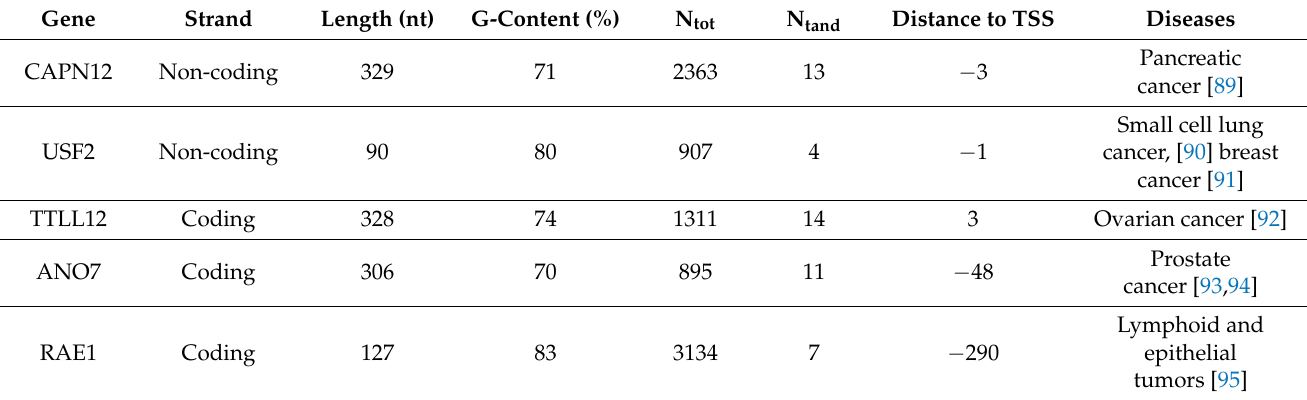
Table 1. A subset of G4CRs with high N tot , N tand , G-content, and length that are found close to the transcription start site for genes which are dysregulated in a number of different